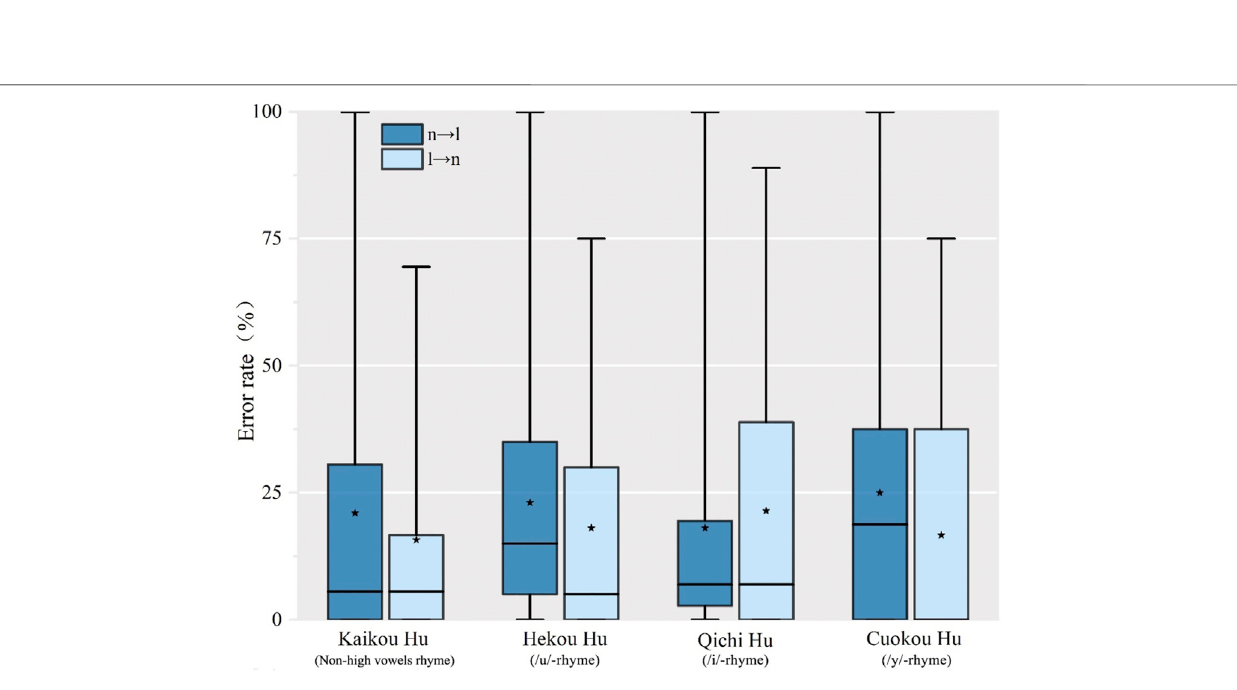
Frontiers in Communication |